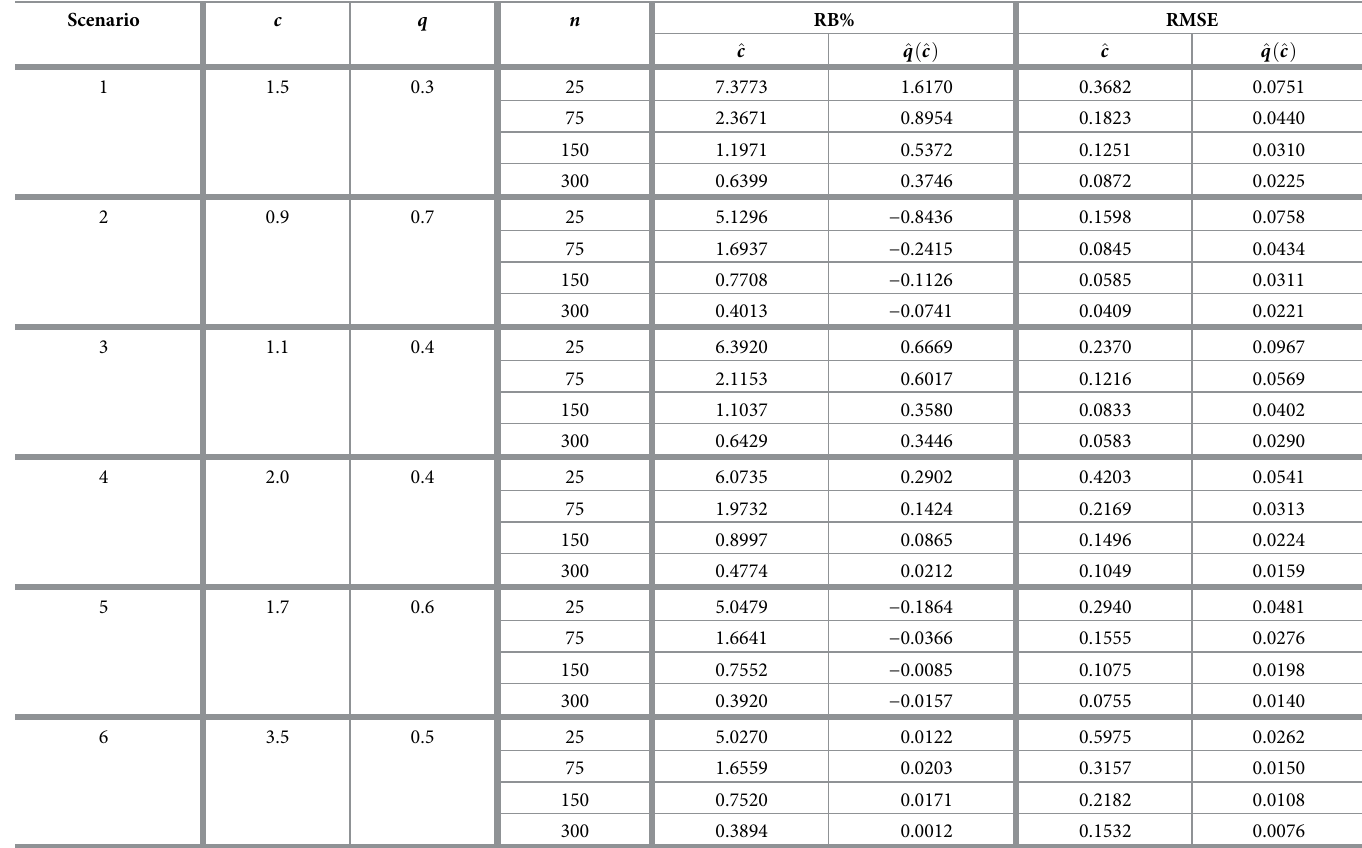
Table 1. RB%s and RMSEs from the UBXII